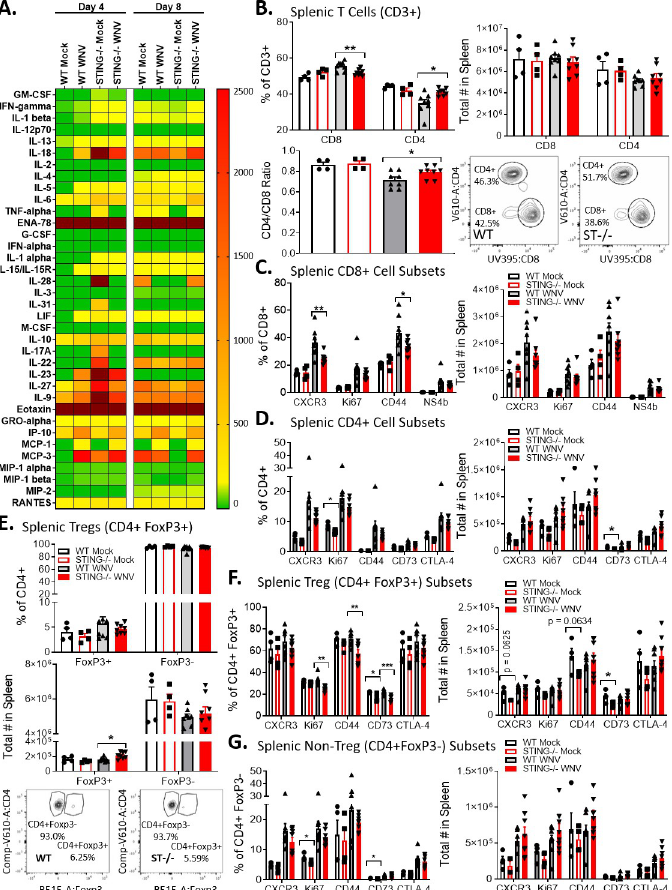
Fig 5. STING is required to program the adaptive immune response during WNV infection. (A) Luminex analysis of cytokines and chemokines from serum in mock (PBS) and WNV infected mice at D4 and D8 post infection. n = 3–8 per condition. Dark red indicates values outside of (above) set scale. (B) CD4+ and CD8+ T cell frequency and absolute number in D8 post infection spleens (top). Flow schematic (bottom left) and CD4/CD8 ratio (bottom right). n = 4–8 per condition. Unpaired students t-test; p = 0.05 � ; p = 0.005 � ; p = 0.0005 ��� ). (C) Characterization of D8 pi splenic CD8+ T cell sub-populations (CXCR3+, Ki67+, CD44+ and NS4b+). Left: frequency; Right: Absolute number. n = 4–8 per condition. Unpaired students t-test; p = 0.05 � ; p = 0.005 � ; p = 0.0005 ��� ). (D) Characterization of D8 pi splenic CD4+ T cell sub-populations (CXCR3+, Ki67+, CD44+, CD73+ and CTLA-4+). Left: frequency;